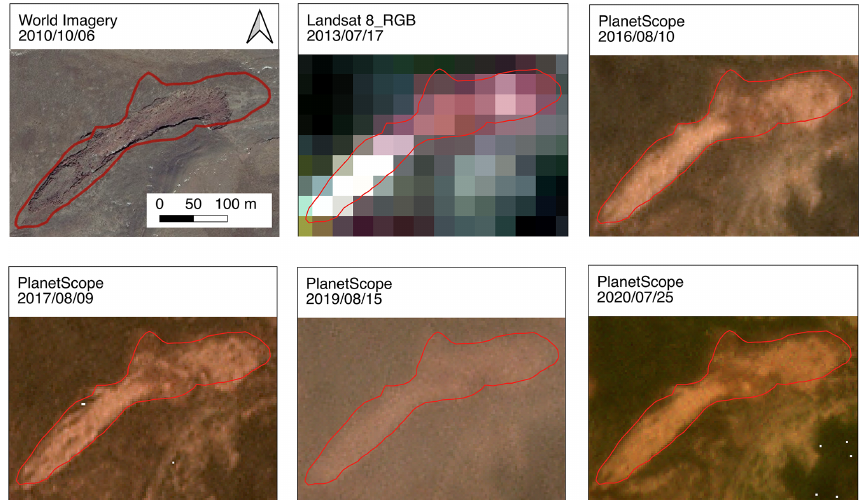
Figure 4. Temporal images of an RTS from various remote sensing data sources, including PlanetScope images (© Planet Labs Inc), Landsat images, and World Imagery (Esri Inc., 2018). The image from World Imagery cannot be downloaded, so it was a screenshot without a scale. The ID of this RTS is 166. The red polygons represent the boundaries of the RTS, based on the 2019 PlanetScope images.